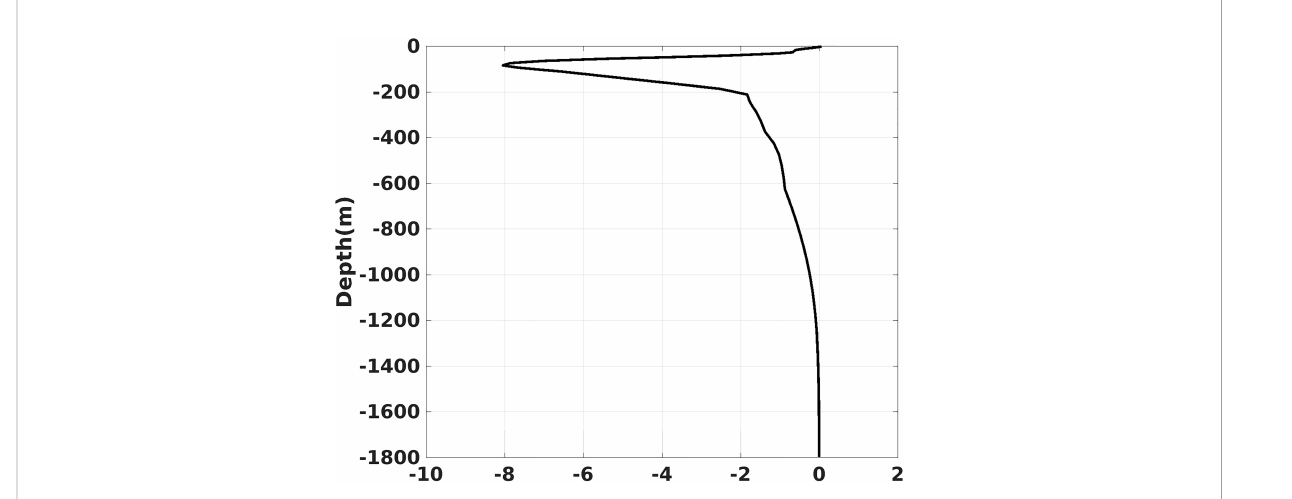
FIGURE 6 The vertical structure function J(z) of potential density of the implanted 3D